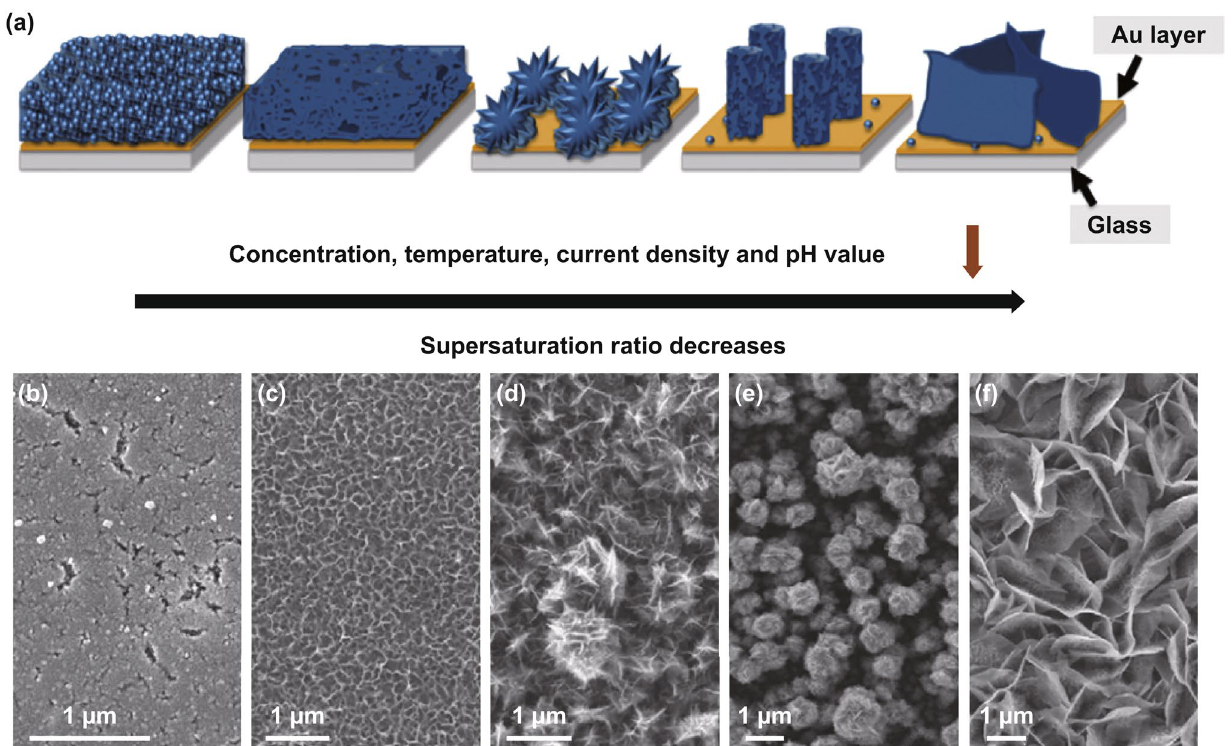
Fig. 17 a Schemes of the morphological evolution of MnO x across different electrodeposition supersaturation ratios. b – d Top‑view SEM images of MnO x electrodeposited in 0.1 M Mn(NO 3 ) 2 aqueous solutions at various current densities: b 20 mA cm −2 , c 1 mA cm −2 , and d 0.1 mA cm −2 . e – f SEM images of MnO x prepared in 0.0025 M Mn(NO 3 ) 2 at e 0.1 mA cm −2 and f 0.05 mA cm −2 . Adapted from Ref. [170] with